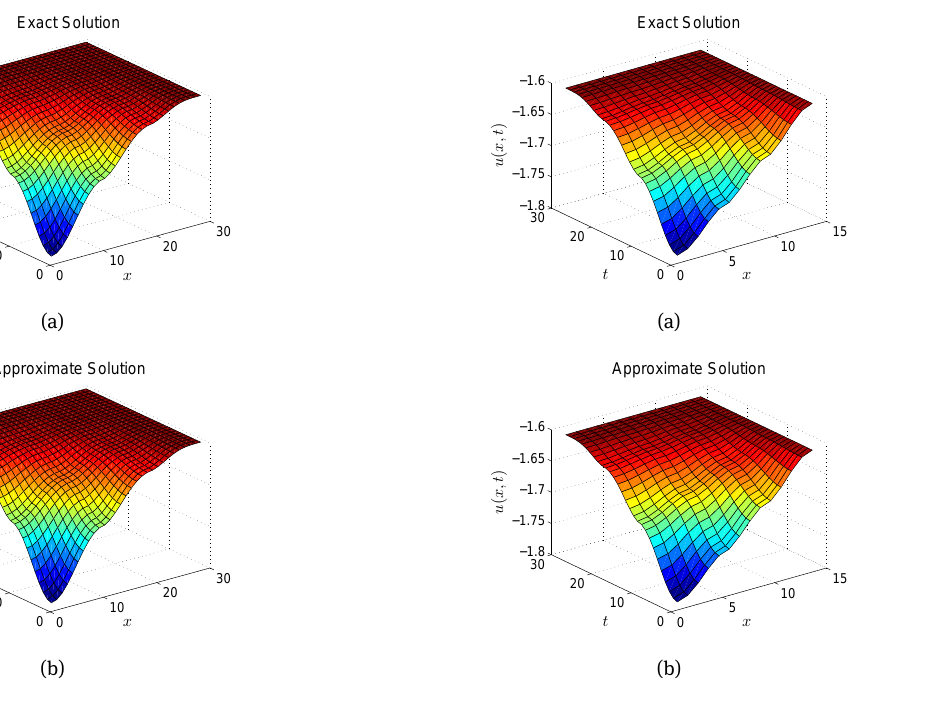
Figure 11: Space-time graph of the exact solution and approximate solution for example 4 when k = 1, p = 2